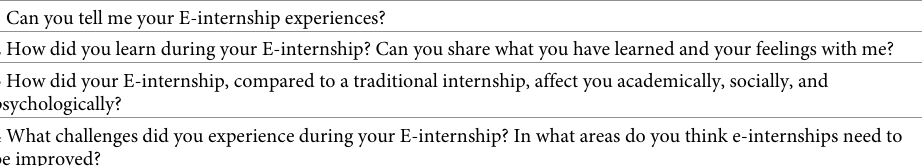
Table 1. Interview